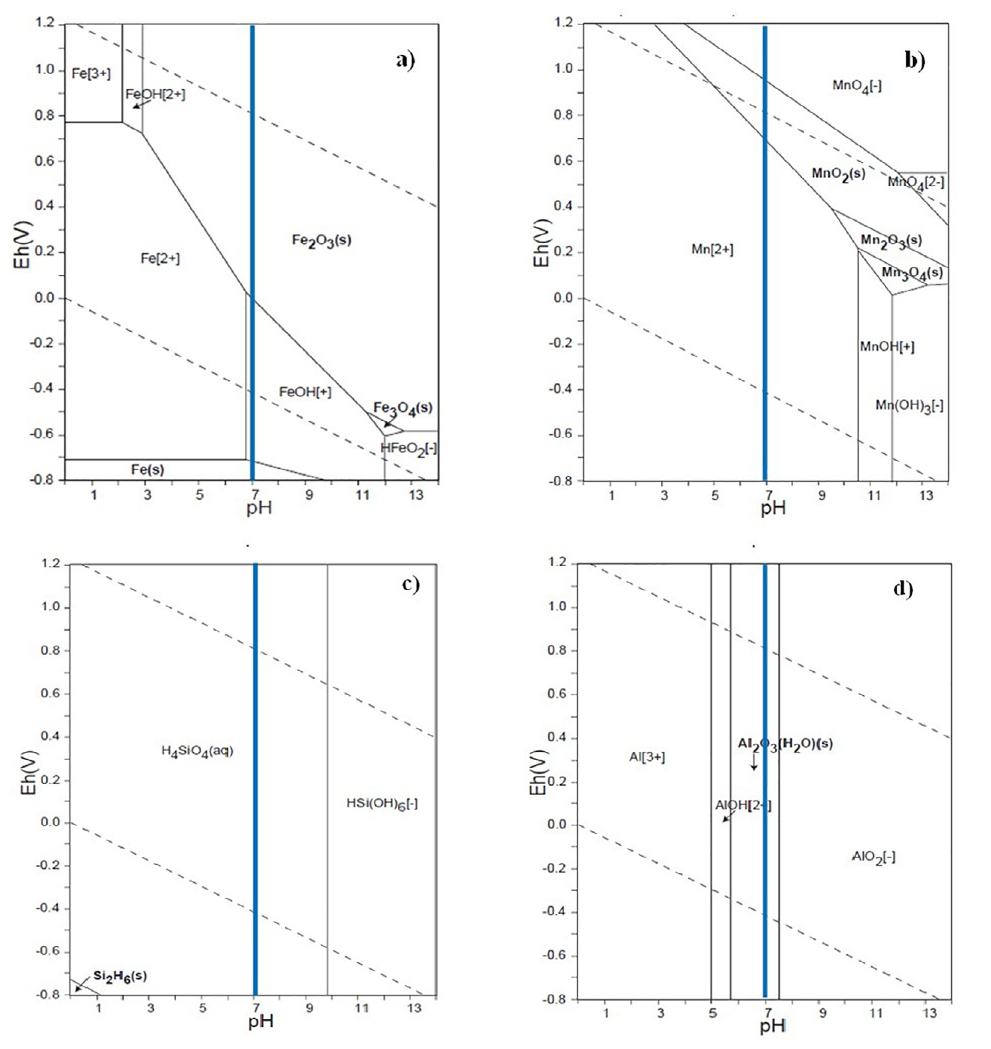
Figure 11. Pourbaix diagrams of Fe, Mn, Si and Al elements. Source: Takeno, 2005 19 . the elements to pass as ions directly to the electrolyte 9 .It is also possible to observe how the lamellae of corrosion products are easily removed, implying their